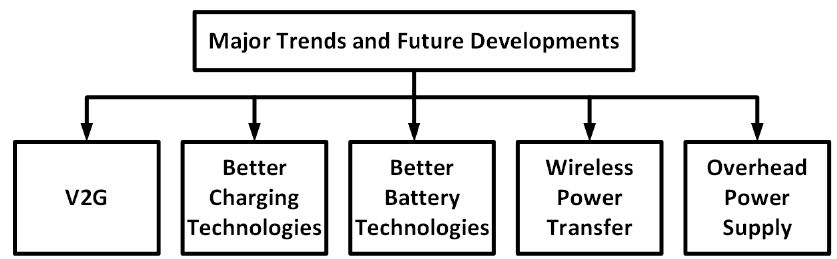
Figure 80. Major trends and sectors for future developments for EV.